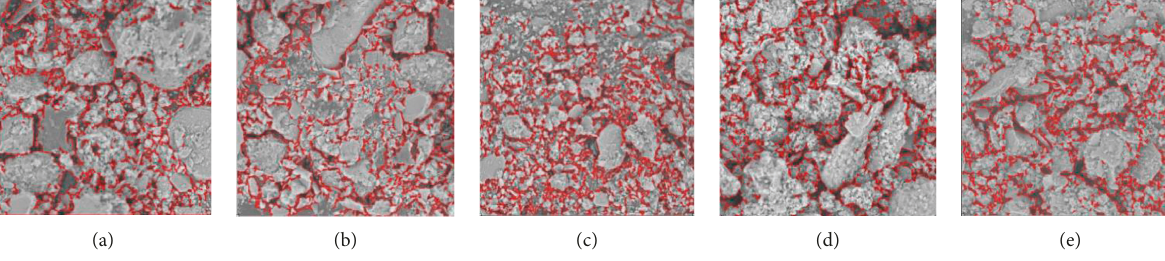
Figure 9: Selection of AOI area and the effect of image processing: (a) 75% fine sand + 25% silty clay; (b) 50% fine sand + 50% silty clay; (c) 25% fine sand + 75% silty clay; (d) 50% clay + 50% silty clay; (e) 50% clay + 50% fine